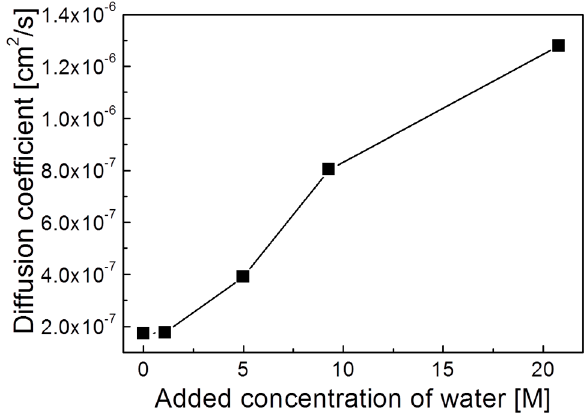
Figure 2. Diffusion coefficient depending on the concentration of the added water.